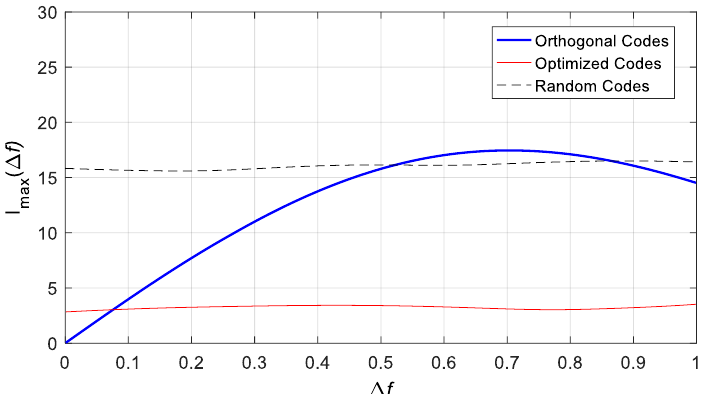
Figure 7. Comparison of the interference power 𝐼 𝑚𝑎𝑥 (Δ𝑓) .